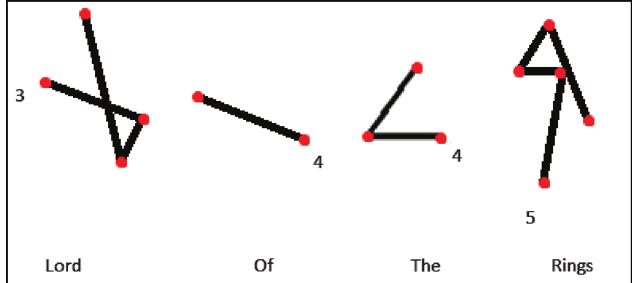
Figure 10. Pattern for “Lord Of The Rings” with a Different Line